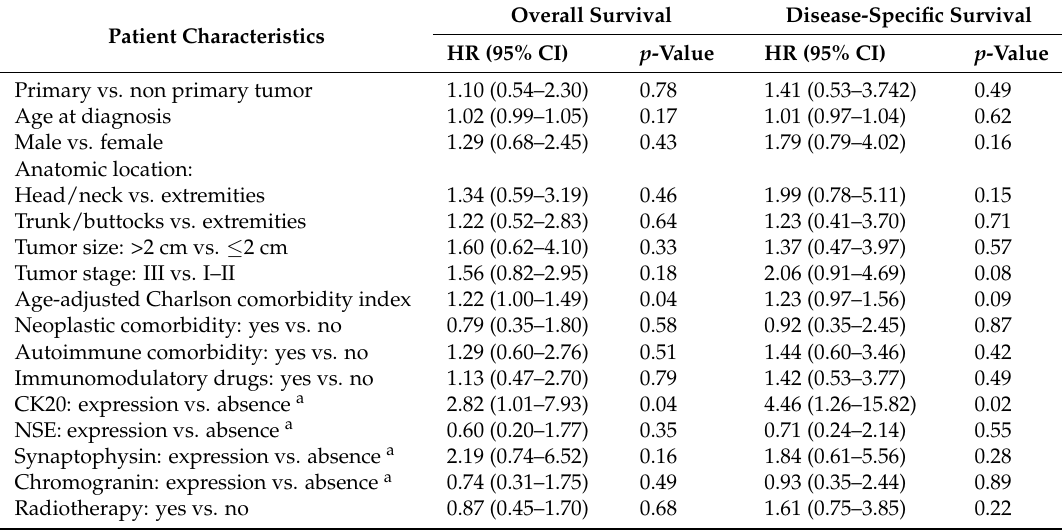
Table 2. Univariate analysis of overall survival and disease-specific survival in patients with tumor stage